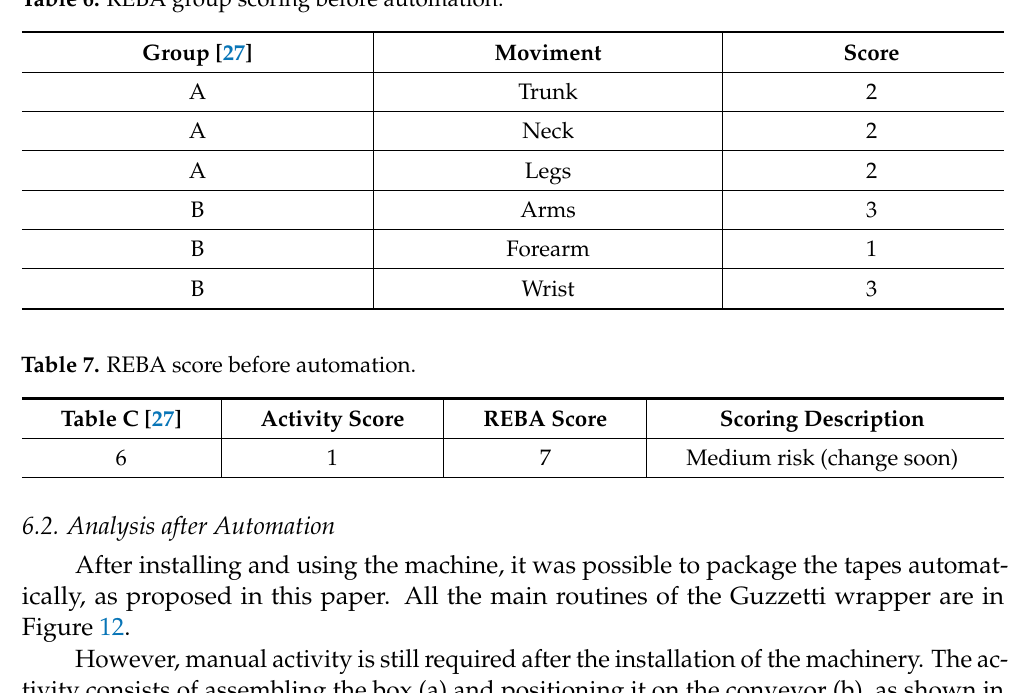
Table 6. REBA group scoring before automation.